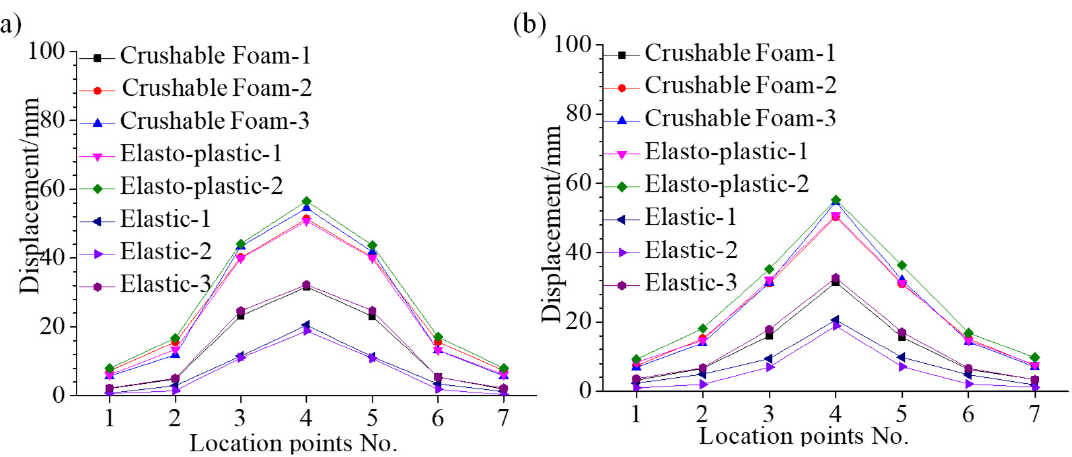
Figure 27. Comparison of deformations using different ice material models: ( a ) Deformation along line LB 4 ; ( b ) Deformation along line LA 4 .